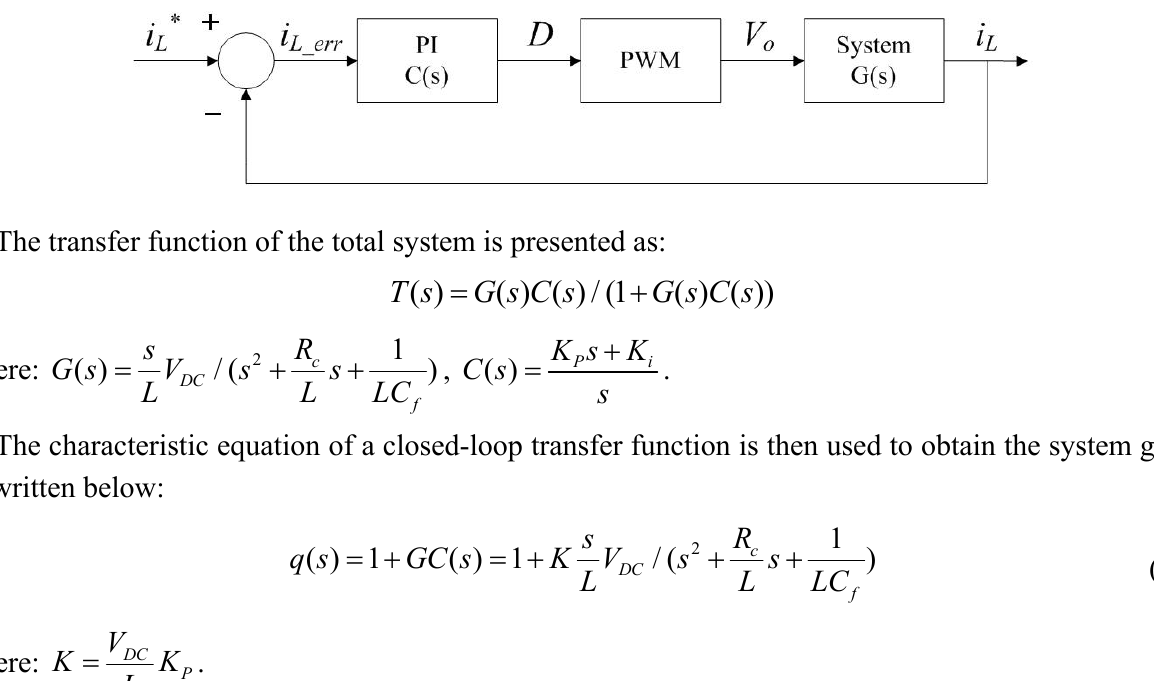
Figure 3. Block diagram of the PI current controller.